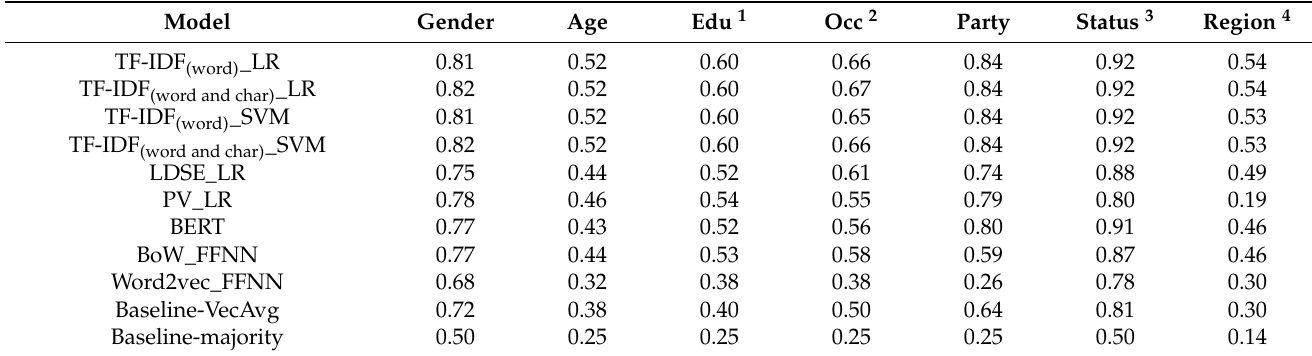
Table 3. Classification accuracies of estimation of demographic traits